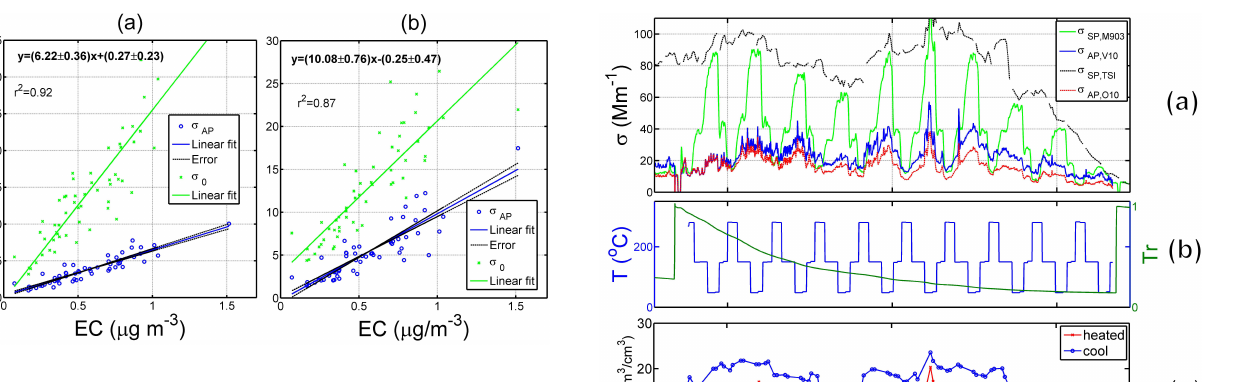
Fig. 5. Mass absorption cross sections (MAC) of soot calculated (a) from aethalometer data at a wavelength of 880mm and OCEC data and (b) from PSAP at a wavelength of 545nm and OCEC from the slope of the linear regression with Nakayama et al. (2010) size dependent correction factors. The errors were calculated using the standard error for ordinary least square regressions. Fig. 6. (a) Light scattering coefficients ( σ SP , M903 (heated) at λ =545nm and σ SP , TSI (cool) at λ =550nm), light absorption coeffi- cients ( σ AP , V10 at λ =545nm and σ AP , O10 at λ =545nm), (b) oven temperature ( T ) and PSAP transmittance (Tr), and (c) the volume of the measured aerosol during the temperature scans.